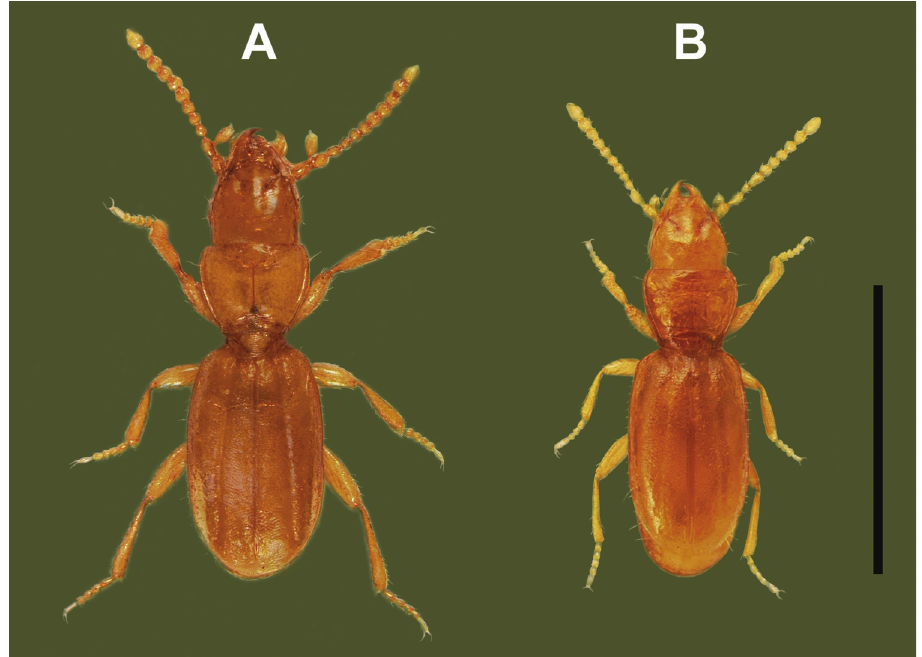
Figure 6. Digital images of habitus of Pelodiaetus s pecies, dorsal aspect. A P. sulcatipennis (NZ, Otago, Outram) B P. nunni (NZ, Canterbury, Ahuriri Scenic Reserve). Scale bar: 1.0 mm.